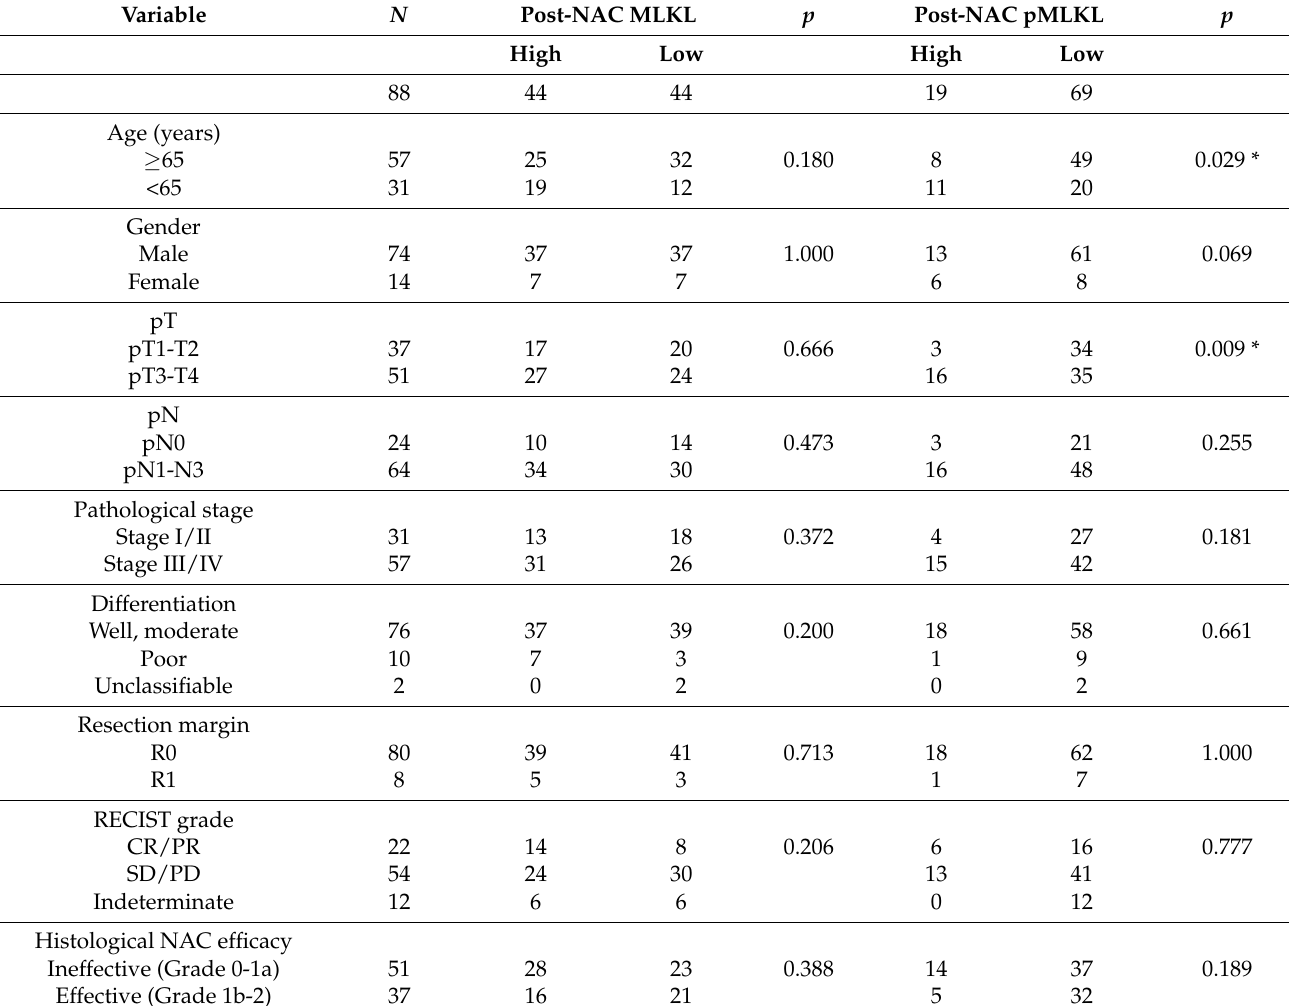
Table 1. Post-NAC expression status of the markers and its correlation with clinicopathological factors.